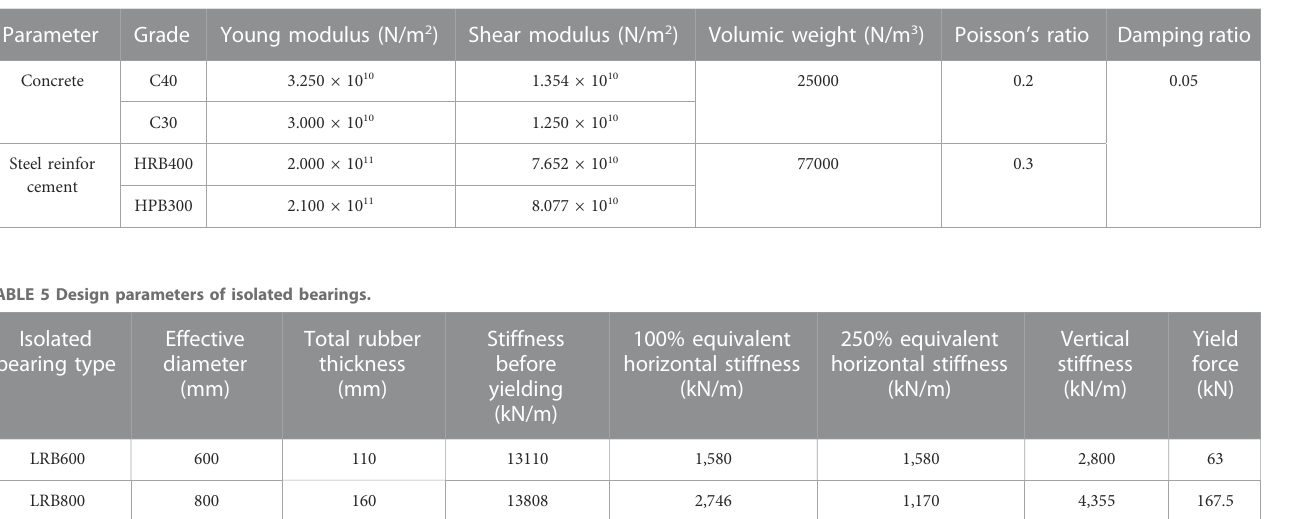
TABLE 4 Parameters of the material.